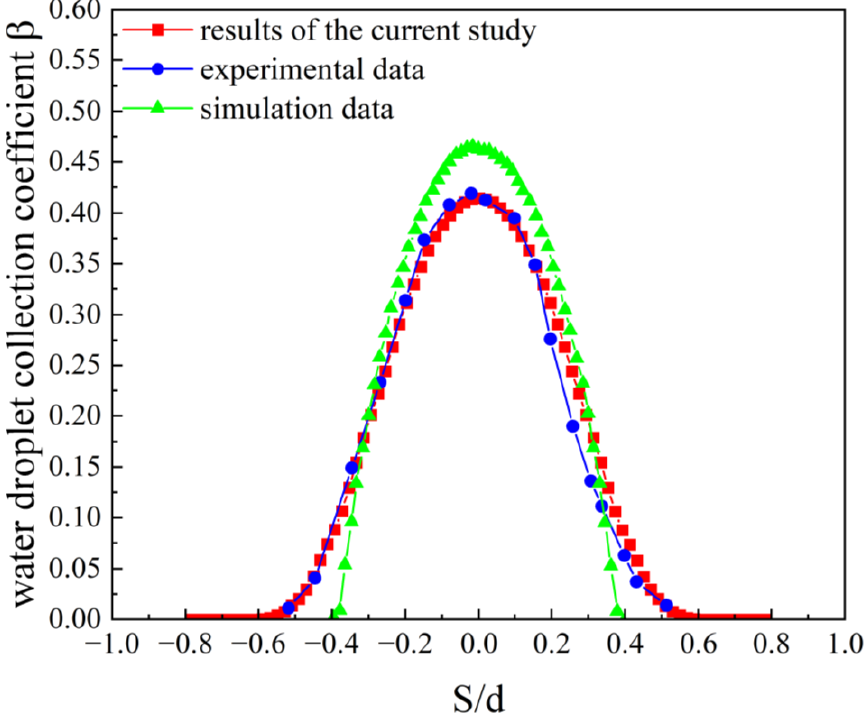
Figure 1. Verification of the calculation method by comparing simulation results with experimental data [32] and simulation data [33].